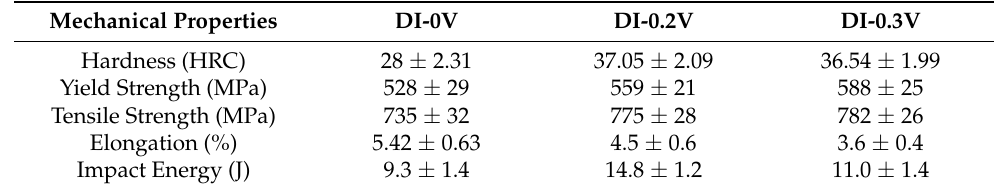
Table 3. Mechanical properties for camshafts unalloyed and alloyed with 0.2 and 0.3 wt %